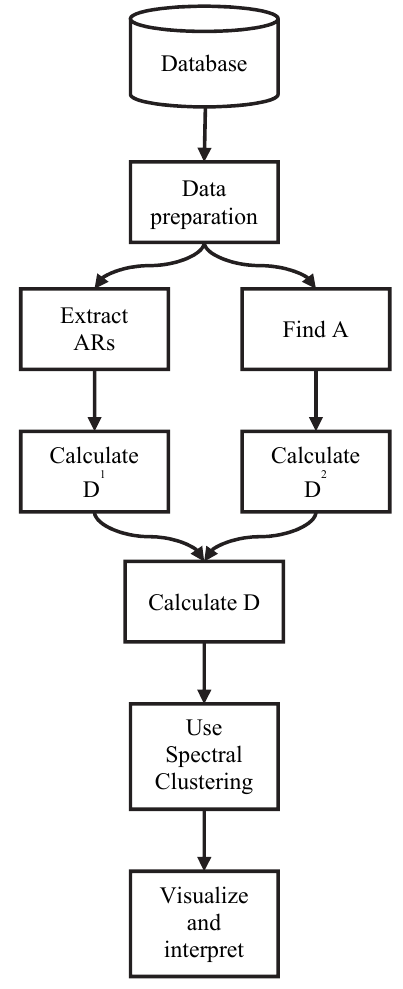
Fig. 3. Proposed methodology (called